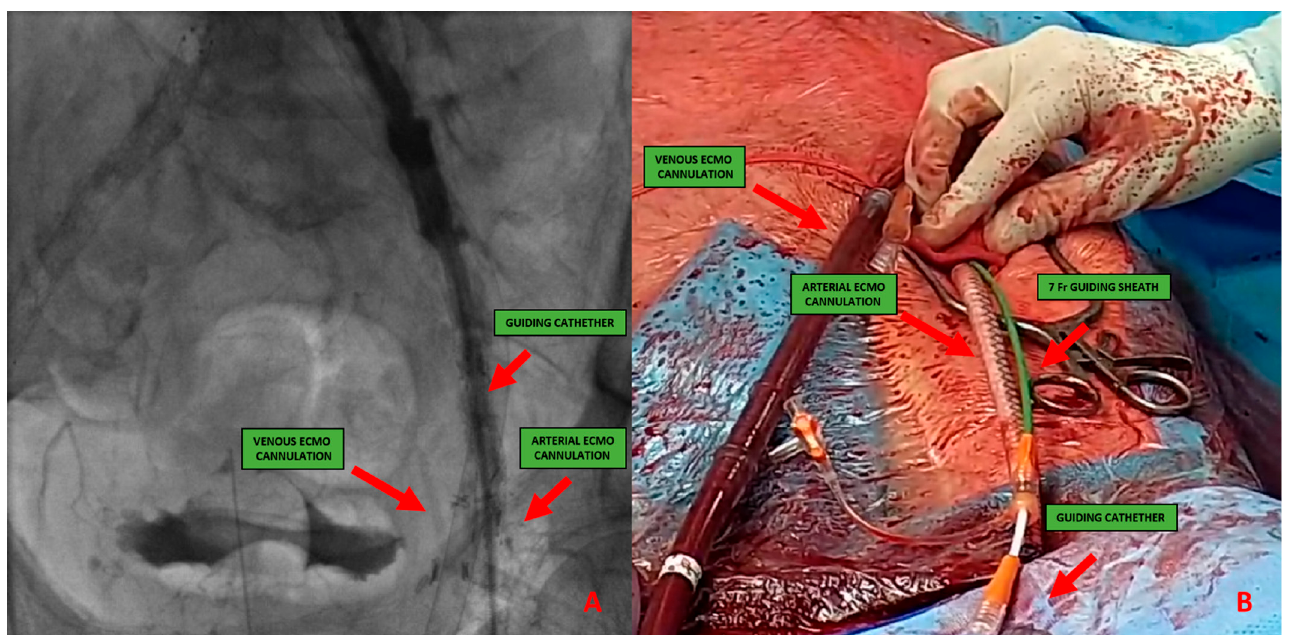
Figure 3. DSA allow to puncture in the correct site of CFA avoiding bifurcation and other small vessels.